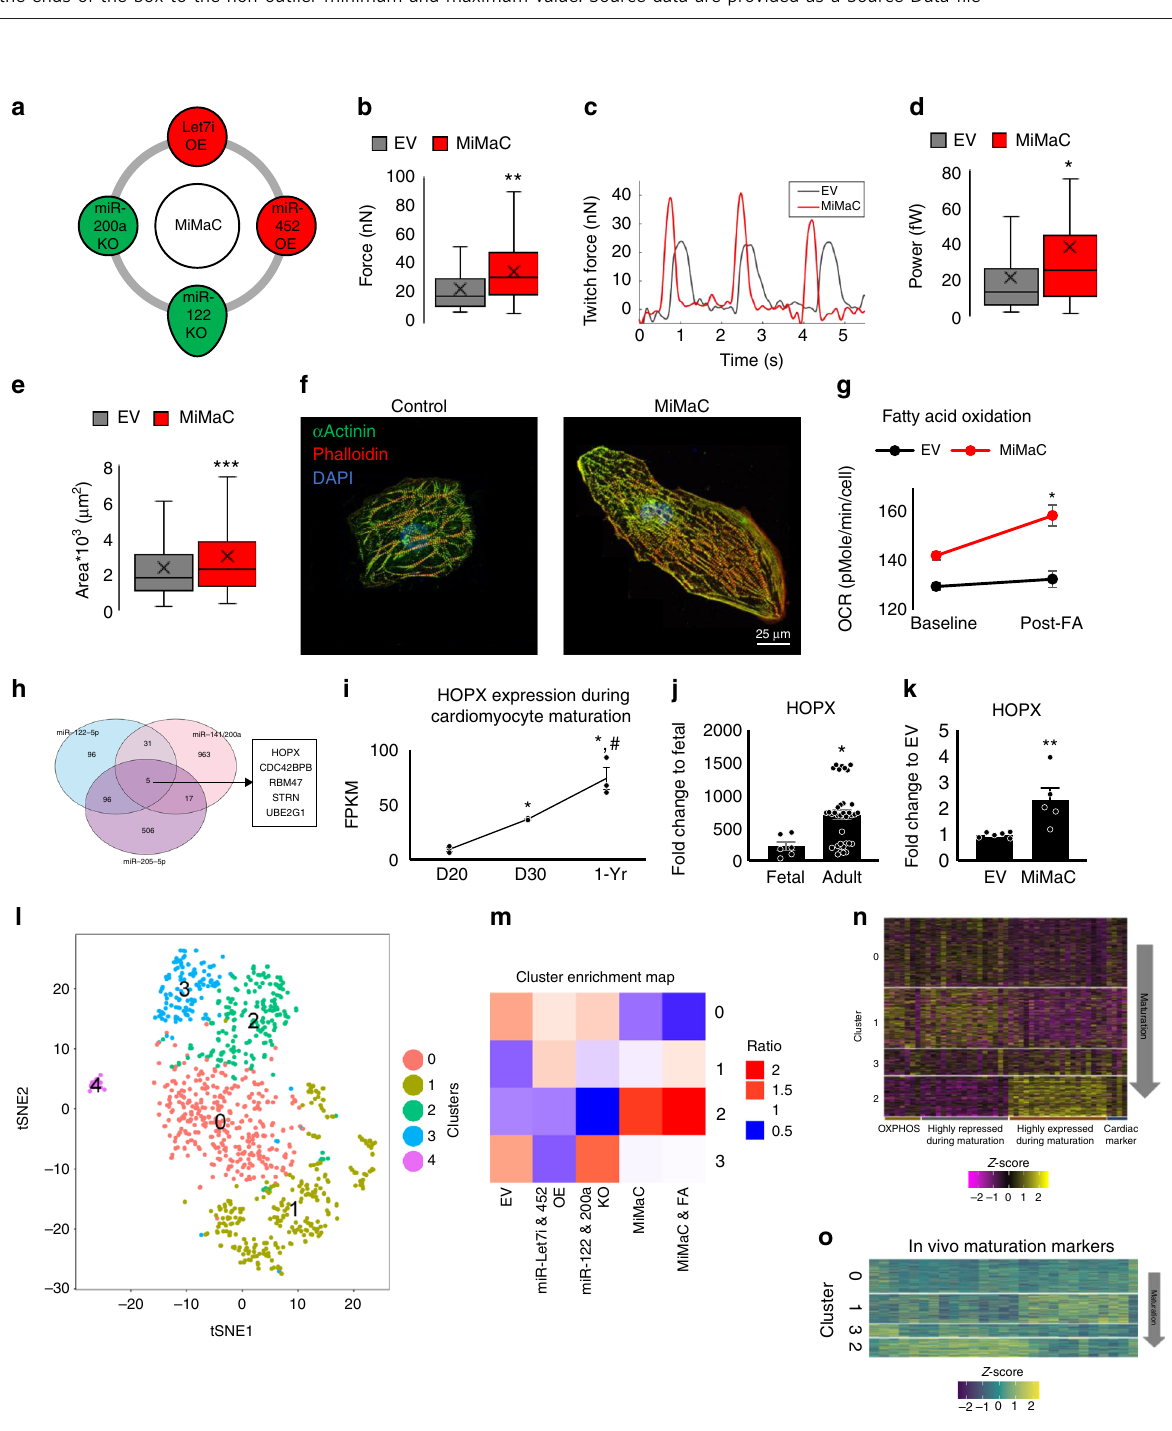
Fig. 2 Cardiomyocyte maturation microRNA screen. a Schematic of the work fl ow performed to determine candidate microRNAs to screen for cardiomyocyte maturation. b Schematic of the work fl ow performed to generate microRNA transduced stem cell derived cardiomyocytes. c Cell area analysis of microRNA treated hiPSC-CMs. MicroRNA-208b OE lead to a signi fi cant increase in cell area while miR-205 KO led to a signi fi cant decrease. EV: 2891 μ m 2 , 208b: 5802 μ m 2 . * p < 0.05, one-way ANOVA on Ranks performed. n = 16 – 51 cells measured. d Micro-electrode array analysis of microRNA treated hiPSC-CMs corrected fi eld potential duration (cFPD). MiR-452 OE led to a longer cFPD. EV: 296 ms, 452: 380 ms. n = 3 – 6 biological replicates. e Single cell twitch force analysis using a micropost assay. MiR-200a KO led to a signi fi cant increase in twitch force of hiPSC-CMs. EV: 30.8nN, miR-200a: 51.7nN. * p < 0.05, one-way ANOVA on Ranks performed. n = 12 – 41 cells measured. f Seahorse analysis of the maximum change in oxygen